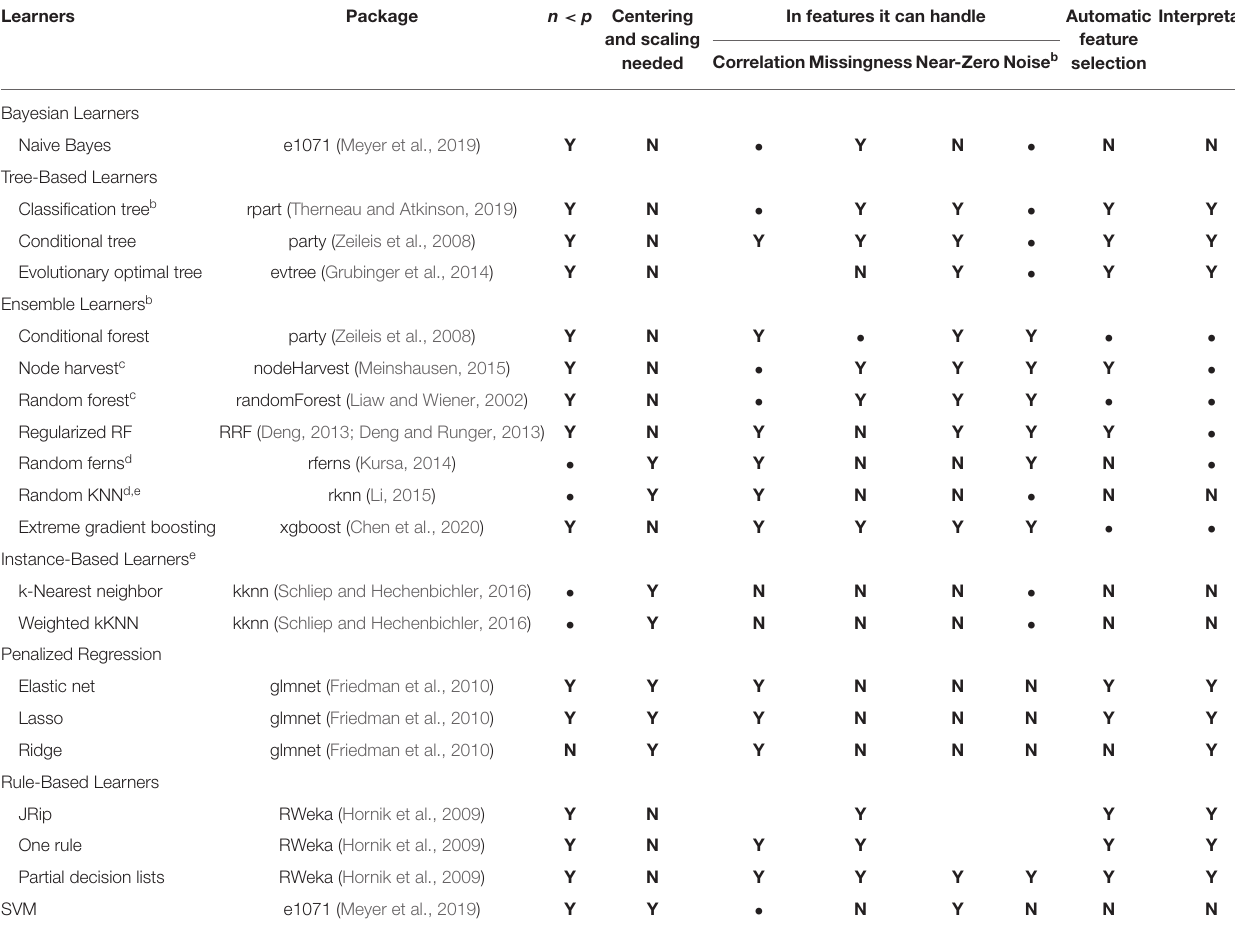
TABLE 2 | List of learners used here, including advantages and disadvantages of each learner as implemented in the R package used here a . Learners Package n < p Centering